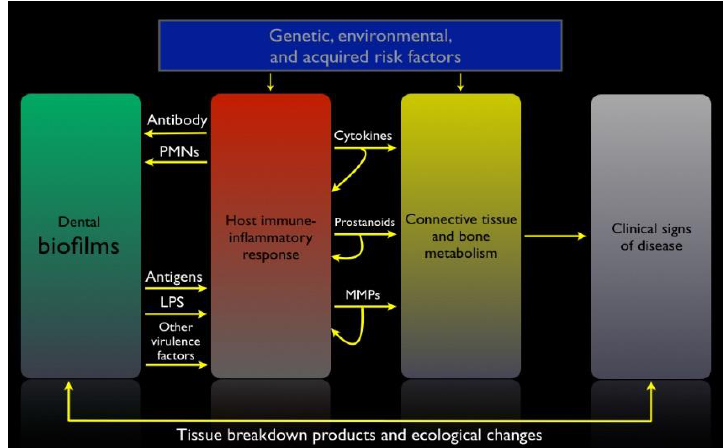
Figure 4. Schematic of the pathogenesis of periodontal and peri-implant diseases (PMNs: polymorphonuclear neutrophils ; MMPs: matrix metalloproteinases; LPS: lipopolysaccharides ). (Adapted from